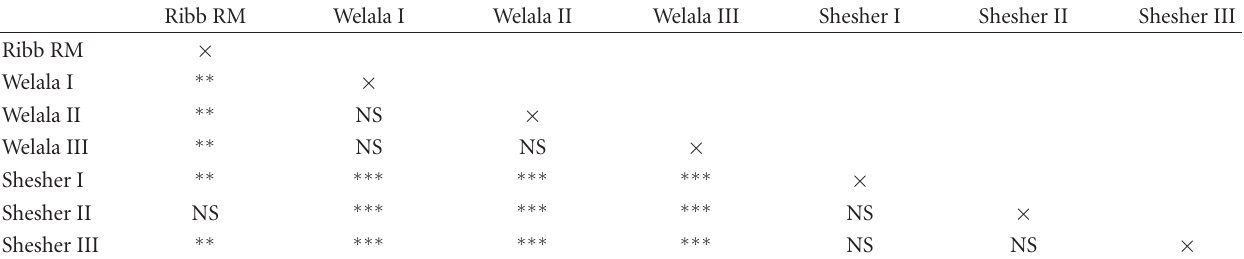
Table 3: Pairwise comparison of dissolved oxygen concentrations (mgL − 1 ) among sampling sites. Abbreviation used: RM = river mouth.